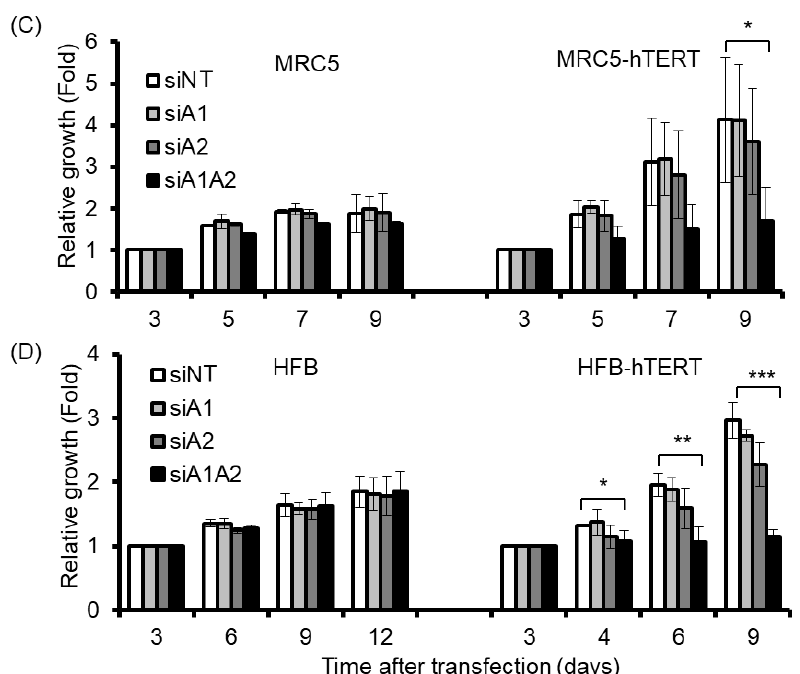
Figure 5. Effects of suppressing hnRNP A1 and/or A2 on cell proliferation of normal fibroblasts and hTERT-immortalized normal fibroblasts. ( A ) Cell lysates from normal fibroblasts (HFF3, MRC5, and HFB) and hTERT-immortalized normal fibroblasts (hFF3-hTERT, MRC5-hTERT, and HFB-hTERT) were assayed for telomerase activity, as described in the materials and methods section. N represents a negative control with no cell extract, while P is a positive control with cell extract from telomerase-positive A549 cells; ( B – D ) Normal fibroblasts and hTERT-immortalized normal fibroblasts were transfected with siRNA targeting hnRNPA1 (siA1), hnRNPA2 (siA2), both hnRNP A1 and A2 (siA1/A2), or with a non-targeting sequence (siNT) for 72 h. Transfected cells were cultured in regular medium and monitored for cell proliferation using trypan blue staining. The results shown are pooled from 2 independent experiments. * p < 0.05, ** p < 0.01 and *** p < 0.001 versus siNT control.